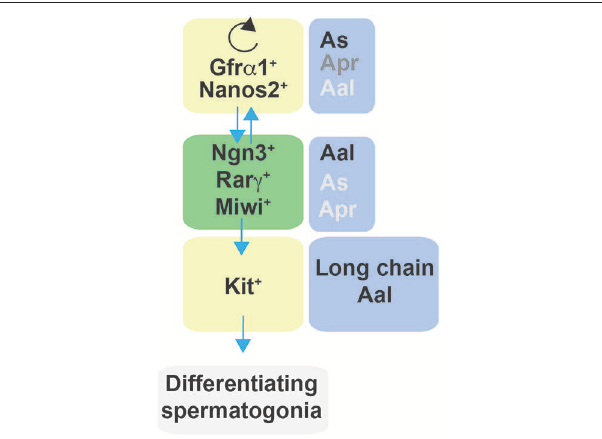
FIGURE 7 | Schematic representation of factors affecting self-renewal and differentiation of spermatogonia in mice. Spermatogonia are classified as Asingle (As), Apaired (Apr), and Aaligned (Aal) according to the number of cells contained in a syncytium. In steady-state, a subset of Gfr α 1/Nanos2 expressing cells function as stem cells with the ability to self-renew their population. Gfr α 1 + spermatogonia have the ability to generate cells that lose the expression of Gfr α 1 and become Ngn3 + /Rar γ + /Miwi2 + , which can retain the stem cell potential but mostly become Kit + cells, and therefore are committed to terminal differentiation. In regenerative contexts, Ngn3 + /Rar γ + /Miwi2 + can regain Gfr α 1 expression contributing to the self-renewing